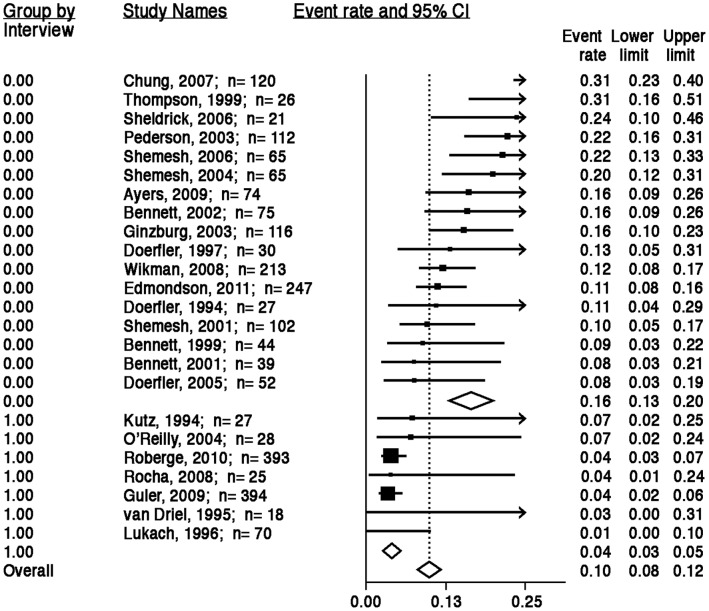
ACS-induced PTSD prevalence estimates by diagnostic interview or screening questionnaire.Note: The area of each square is proportional to the study’s weight in the meta-analysis, and each line represents the confidence interval around the estimate. The diamond represents the aggregate estimate, and its lateral points indicate confidence intervals for this estimate.